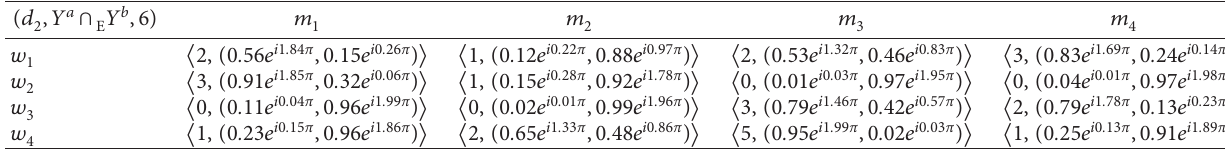
Table 13: Extended intersection.